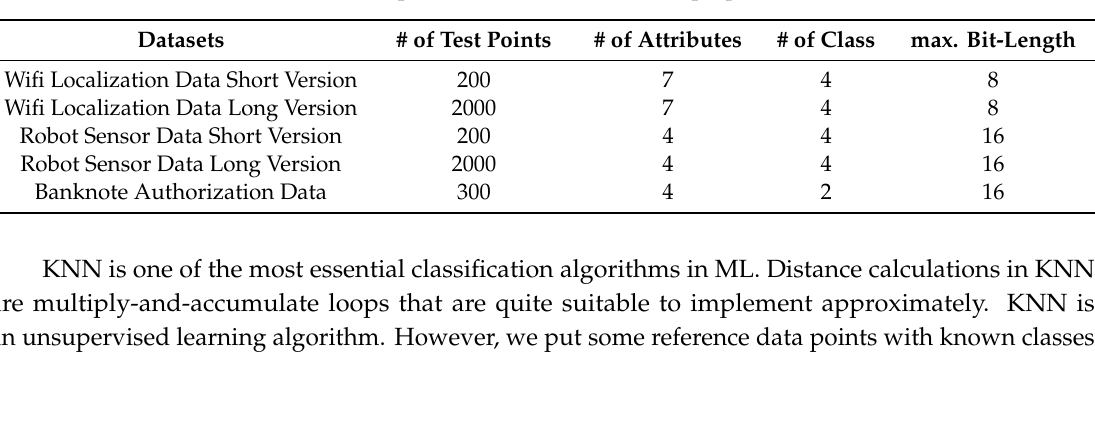
Table 2. Implemented datasets and their